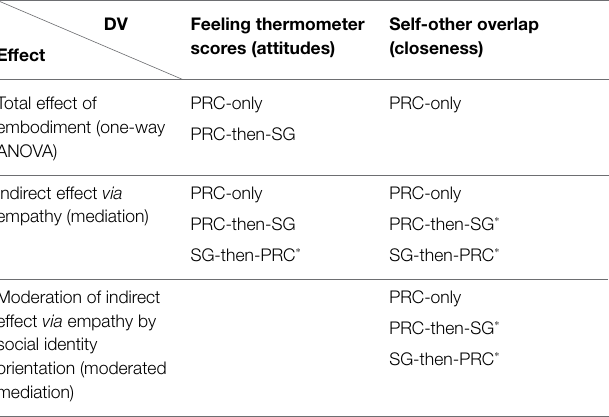
TABLE 3 | Summary of main analyses and significant effects. Cells indicate embodiment conditions that resulted in significant effects (contrasted with the SG-only condition) for each